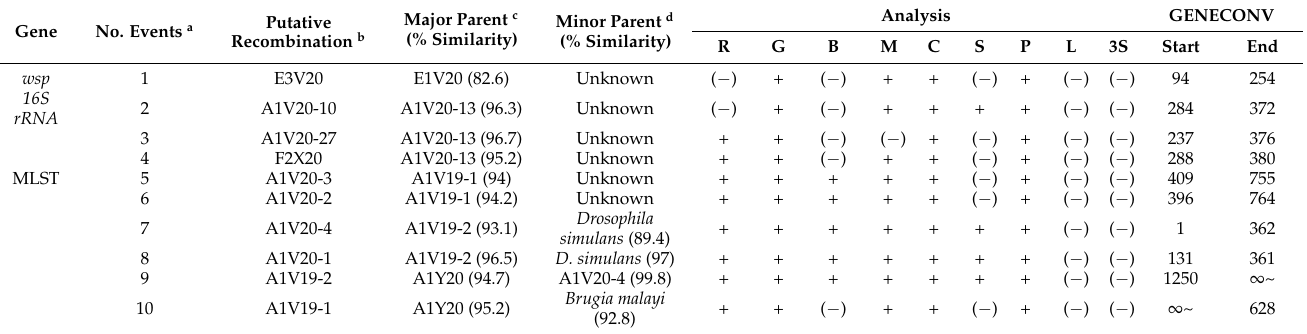
Table 6. Intragenic recombination in wAlec by using nine different methods implemented in RDP5